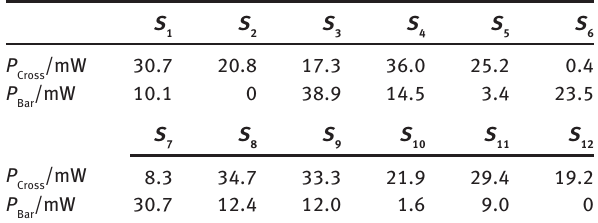
Table 2: Power consumptions of each optical switching unit.